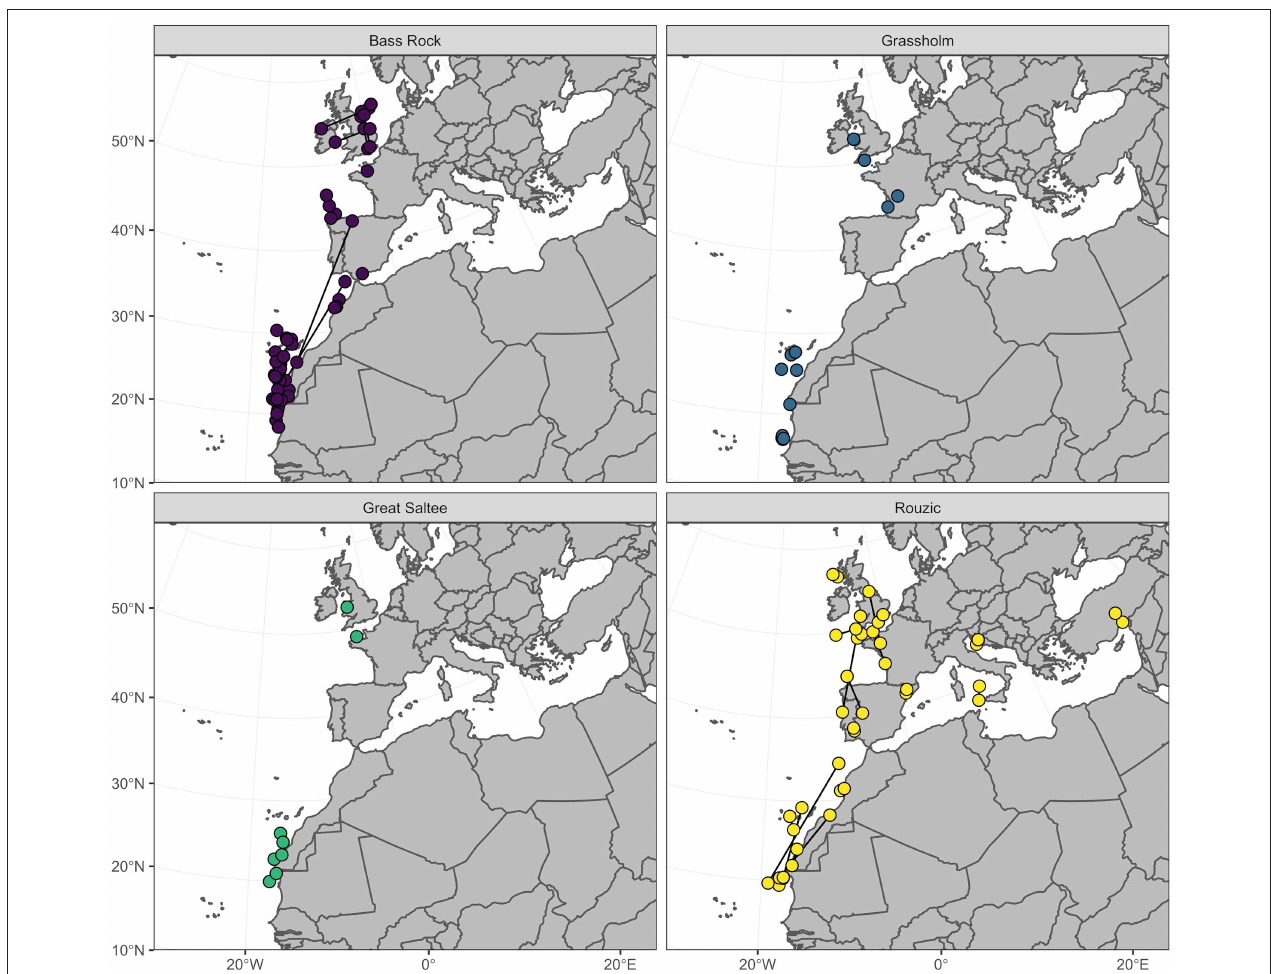
FIGURE 2 | Centroid December location of northern gannets ( n = 77) tracked from four colonies in the North East Atlantic. Dark lines connect locations of individuals ( n = 43) from Bass Rock and Rouzic tracked over two consecutive non-breeding periods.